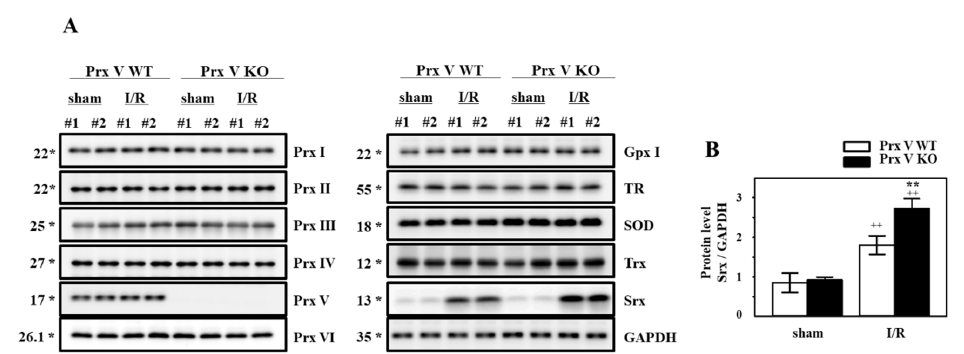
Figure 3. Effect of Prx V ablation on antioxidant proteins during renal I/R. ( A ) The expression of antioxidant proteins was analyzed by immunoblotting. ( B ) Srx protein level in ( A ) was quantified by Multi Gauge V3.0 software and normalized to GAPDH. Data are shown as means ± SE. n = 4–6/group * p < 0.05 vs. sham, ** p < 0.01 vs. sham, ++ p < 0.01 vs. sham.